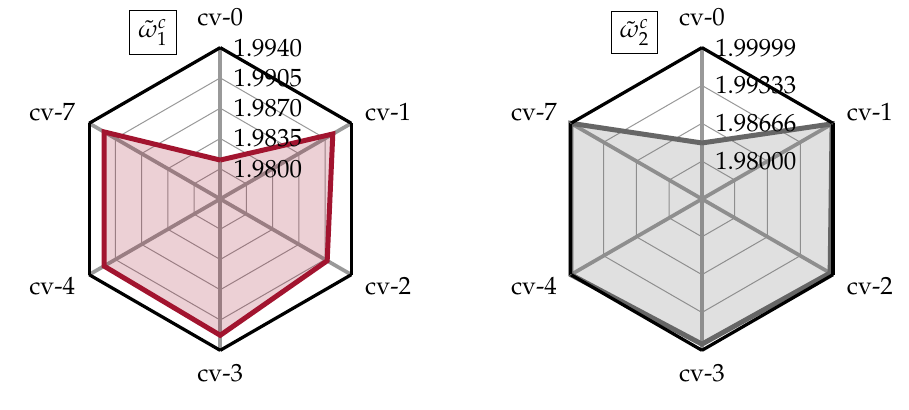
Figure 16. Accuracy and stability range comparison for all collision models with single level and cell-vertex grid.